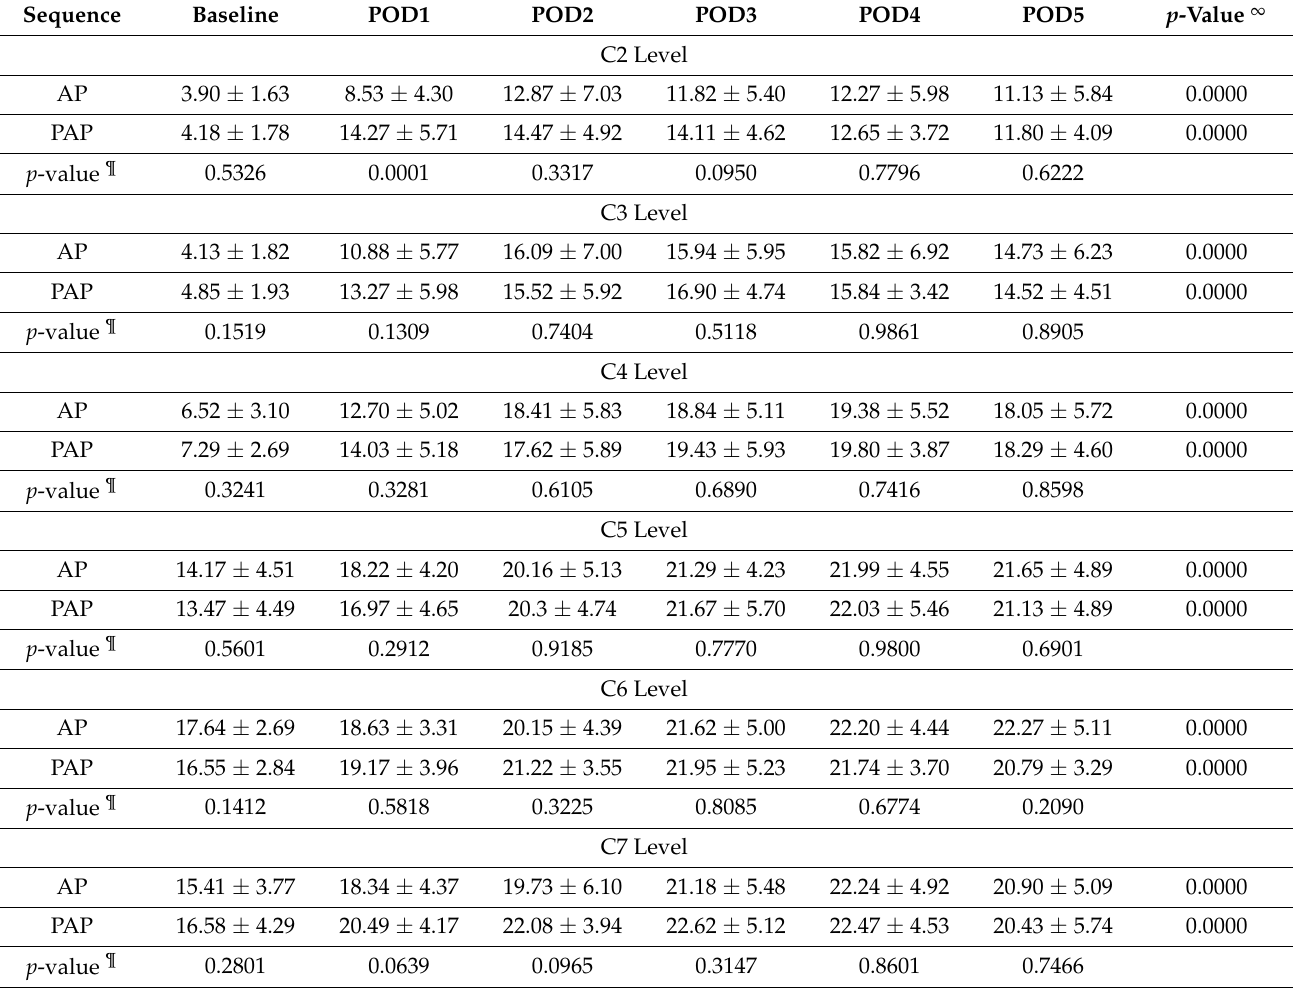
Table 3. PSTS measurements at each cervical level between AP and PAP across the different